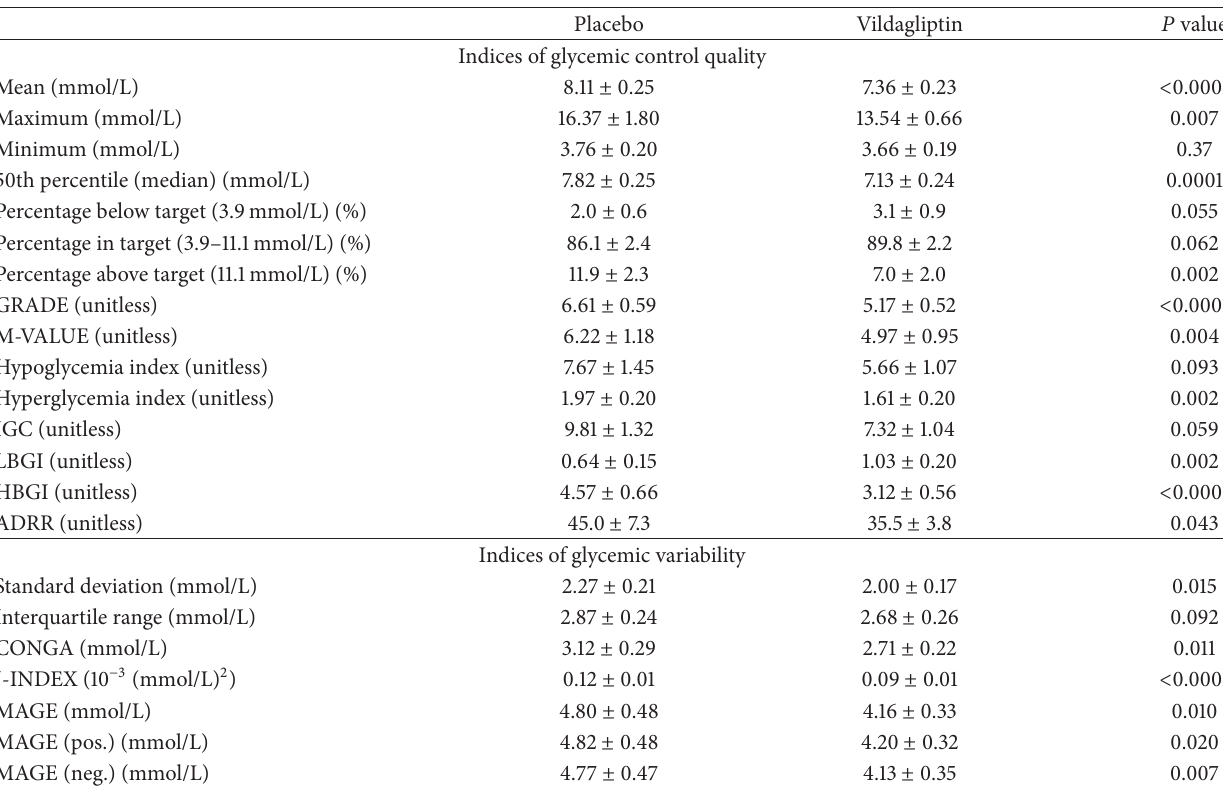
Table 1: Indices of glycemic control quality and glycemic variability in patients with type 2 diabetes after placebo and after vildagliptin (data are mean ± SE). For the explanation of the various indices see the Methods